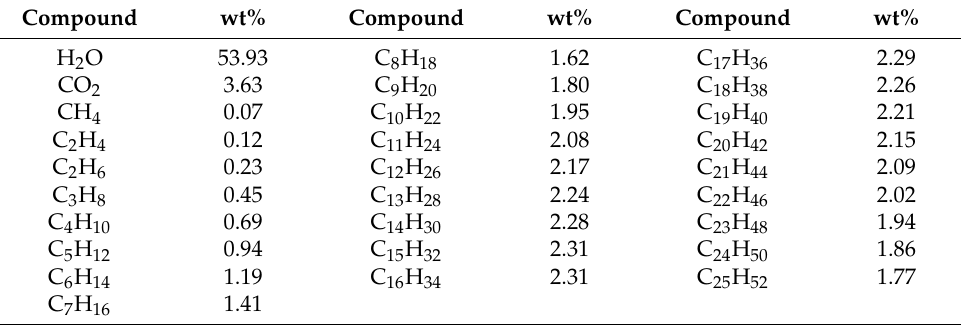
Table 5. Composition of S305 (see Figure